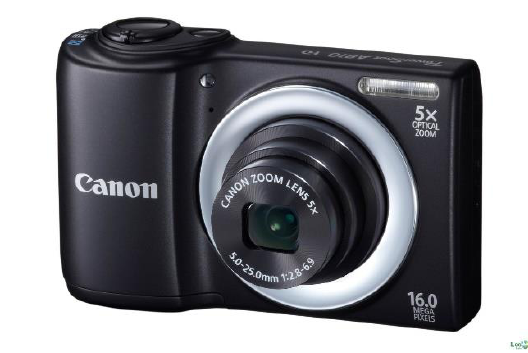
Figure 3. Canon A 180 Camera